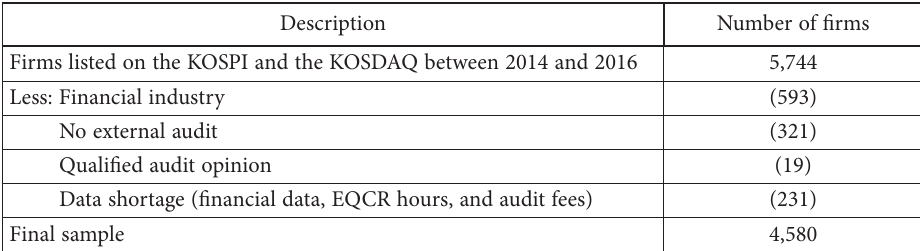
Table 1. Sample selection